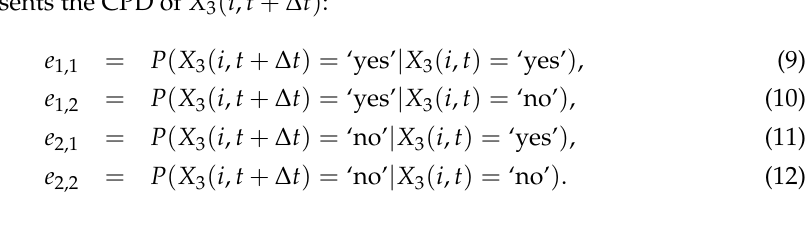
Table 3. CPD of X 3 ( i , t + ∆ t )